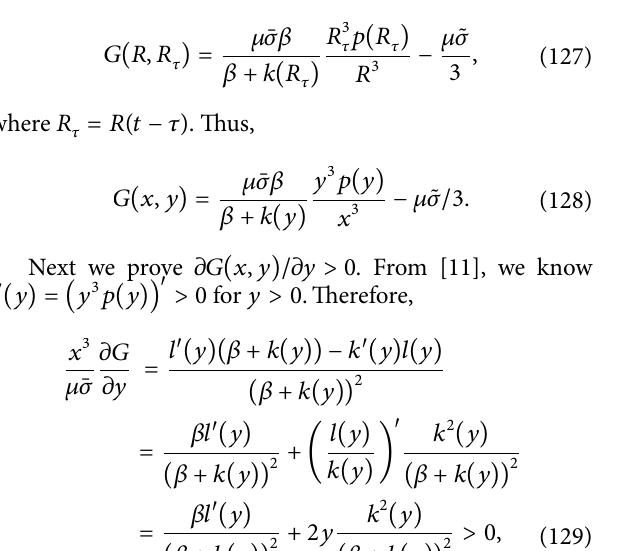
Figure 2: Asymptotic behavior of 휏 = 3, ̃휎 = 3, 훽 = 2,푅 0 = 2, 12.